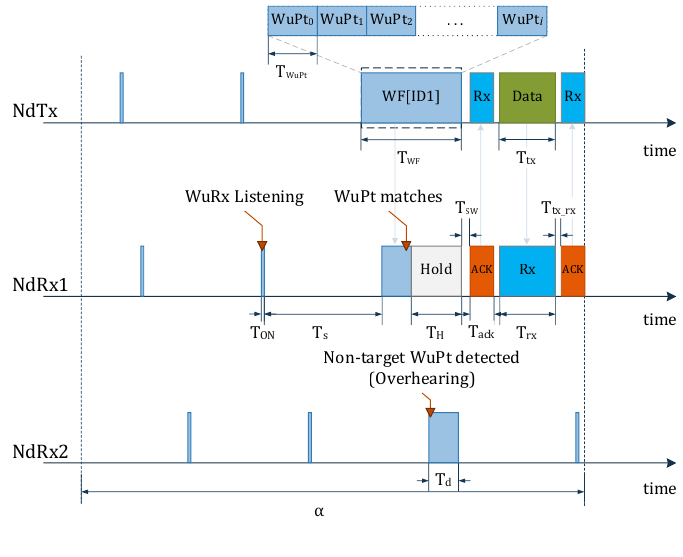
Figure 3. MDCW-MAC